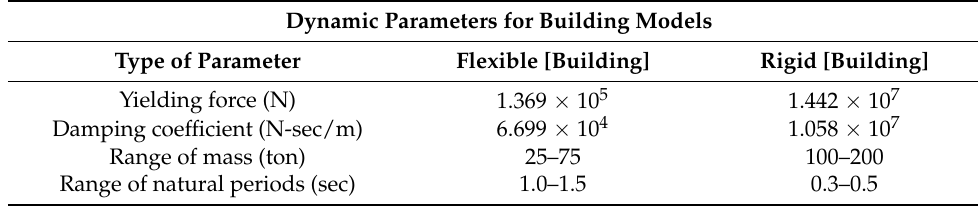
Table 2. Values describing the dynamic characteristics of building models [38 – 40].